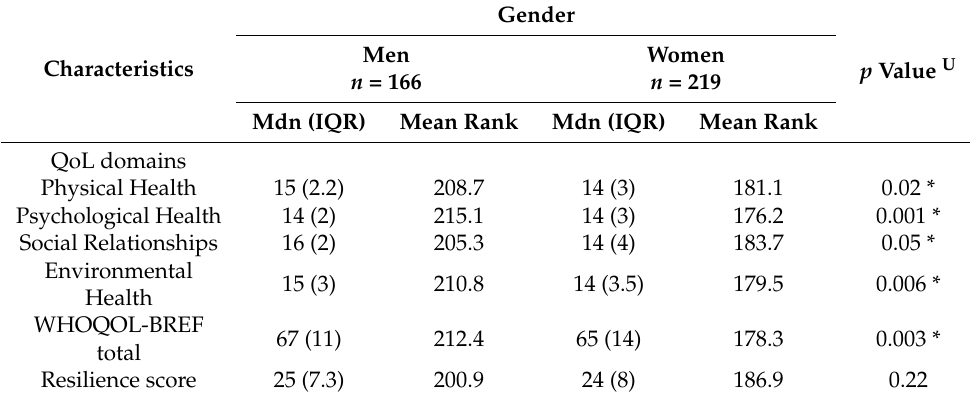
Table 3. A comparison of the WHOQOL-BREF domains and resilience scale based on the gender differences of the study respondents during the COVID 19 pandemic (N = 385).